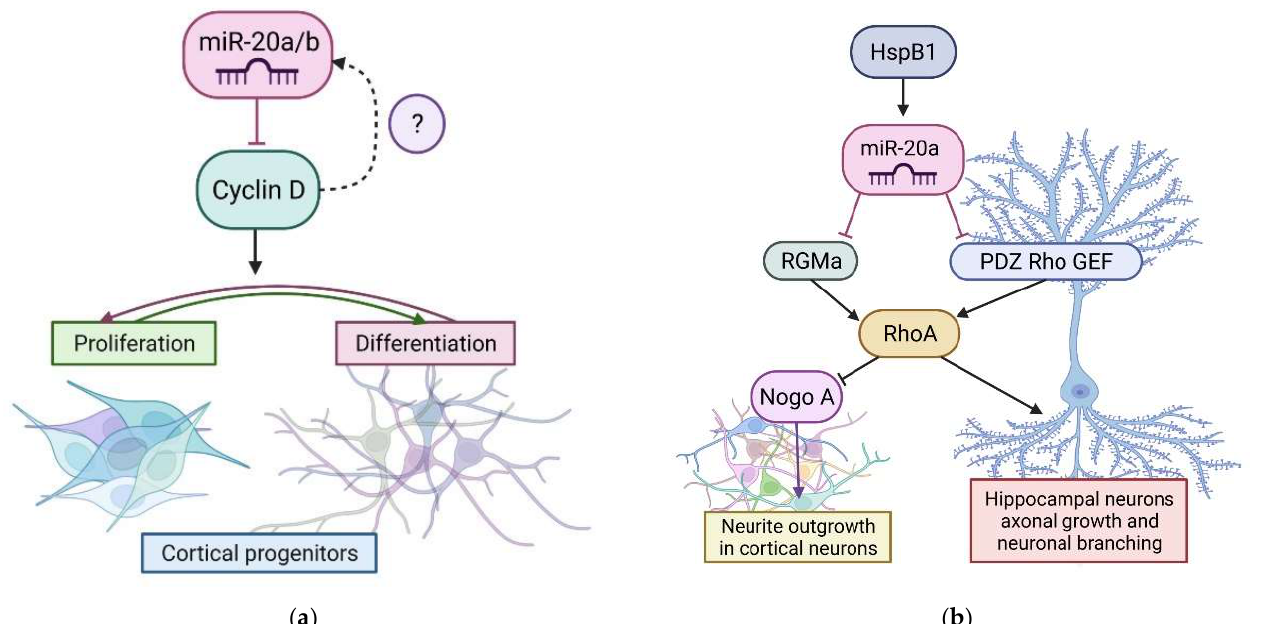
Figure 2. The role of miR-20 in the normal development of the nervous system. ( a ) miR-20a/b regulates developmental stage of cortical neurons by targeting cyclin D1. This regulation underlines fail-safe mechanism. ( b ) Expression of miR-20a can be stimulated by heat shock protein B1 (HspB1), which enhances neurite outgrowth in cortical neurons, and axonal growth and neuronal branching in hippocampal neurons. This image was created using BioRender (accessed on 30 March 2022).